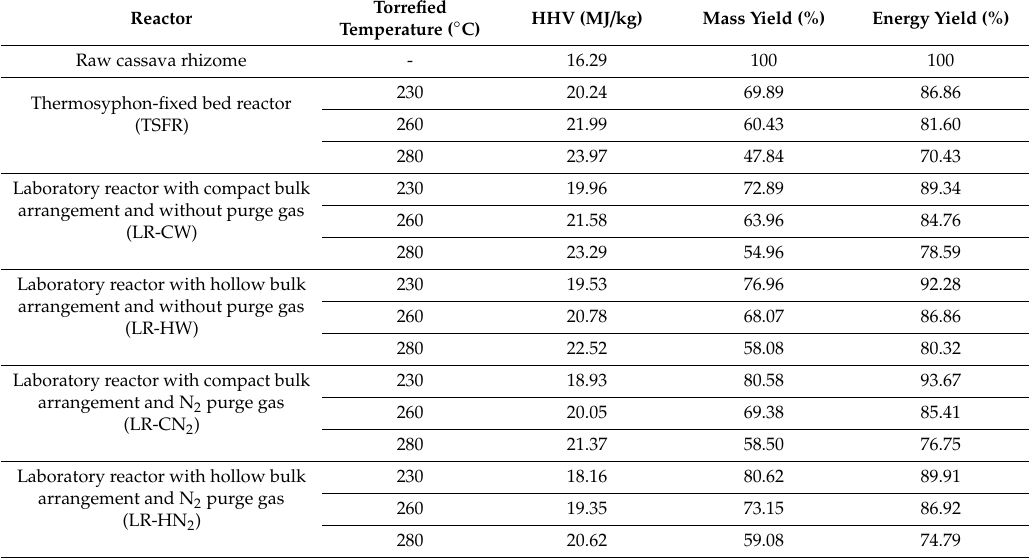
Table 2. The properties of raw cassava rhizome and torrefied char obtained from each reactor. Torrefied Reactor HHV (MJ / kg) Mass Yield (%) Energy Yield (%) Temperature ( ◦ C) Raw cassava rhizome - 16.29 100 100 230